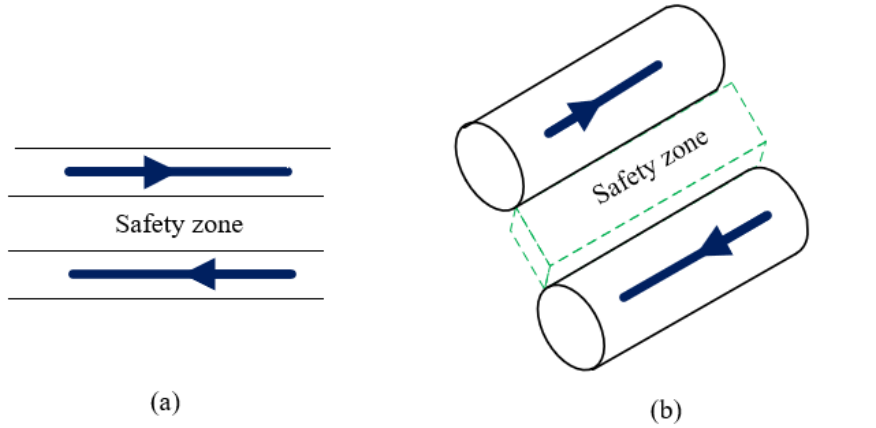
Figure 7. Two ways: ( a ) vertical view, ( b ) 3D view.